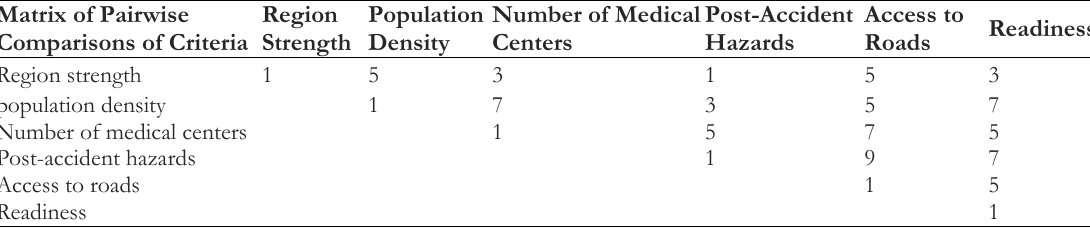
Table 5. Matrixes of pairwise comparison of criteria: a. all criteria; b. post-accident hazards; c. Readiness; d. Population